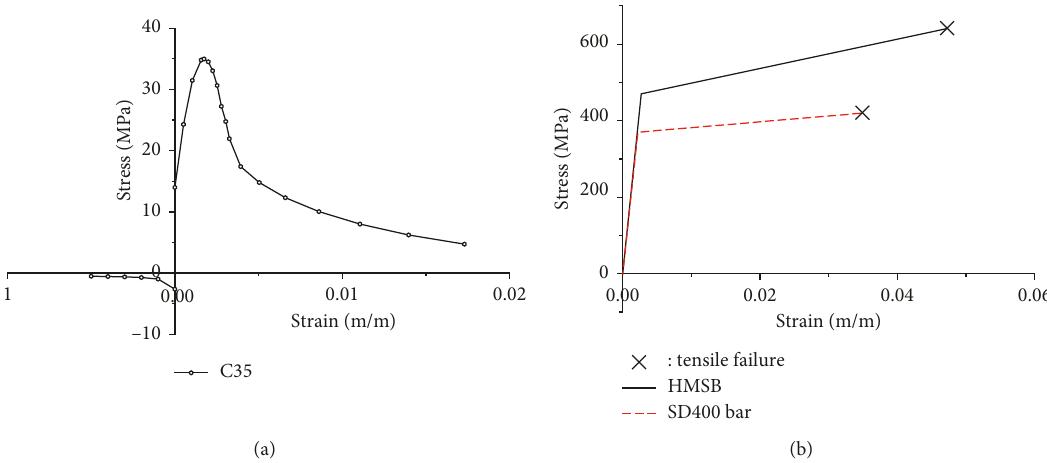
Figure 16: The stress-strain curve used in FEA: (a) concrete and (b) embedded reinforcing